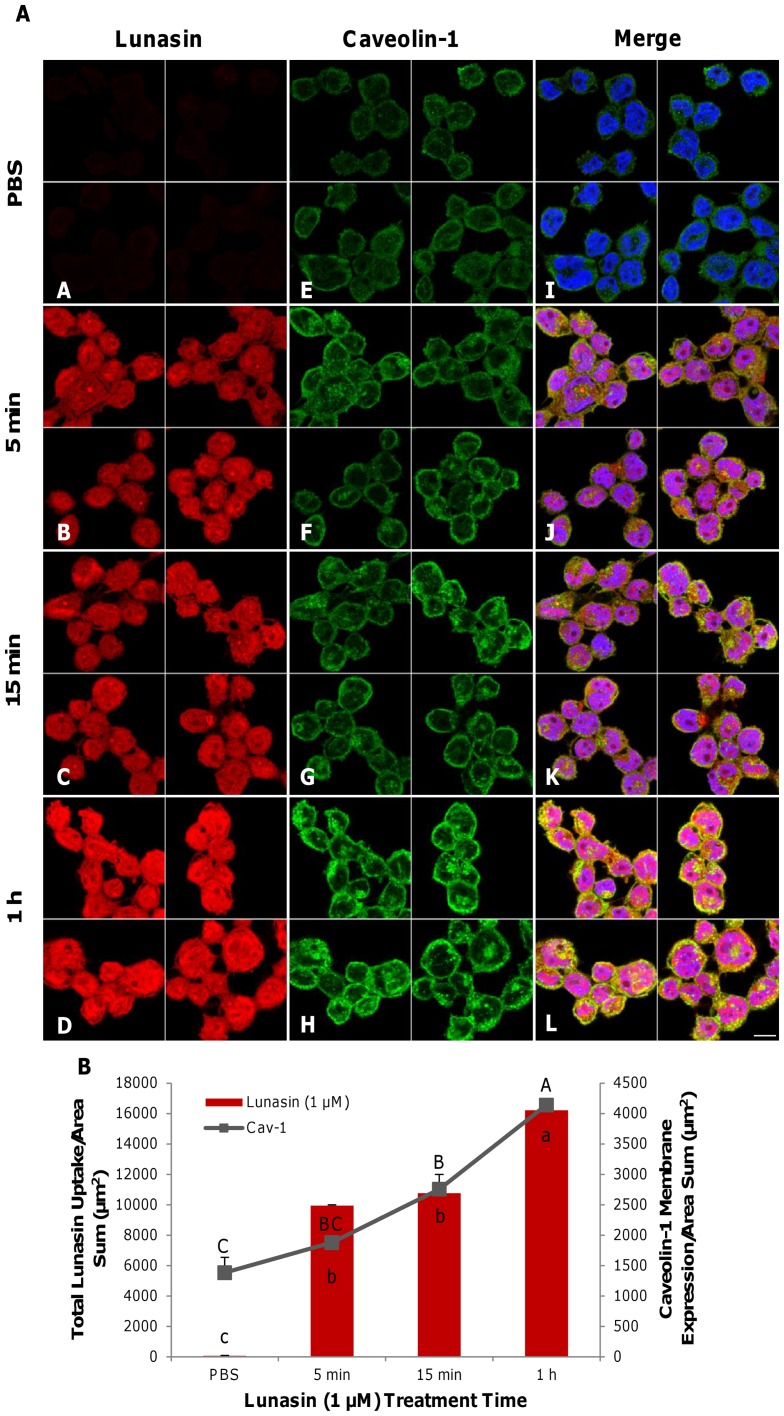
Lunasin promoted the translocation of caveolin-1 to the plasma membrane.Two-dimensional median optical planes showing immunofluorescent localization of lunasin (red), caveolin-1 (green) and nuclei (blue) (
Figure 4A
). Total lunasin uptake by macrophages increased over time (A–D) and treatment upregulated the expression of caveolin-1 at the surface of the plasma membrane (E–H). Immunofluorescence and merged image for lunasin, caveolin-1 and nuclei are shown (I–L). Quantification of the total lunasin uptake and expression of caveolin-1 at the membrane over the time-course of the lunasin treatment (
Figure 4B
). Four independent fields of view from three independent replicates of cells were merged together per treatment group. In Figure 4B, data represent the average of triplicates or quadruplicates ± SE. Capital letters denote statistical values of caveolin-1 expression, whereas lower-case letters represent the statistics for the uptake of lunasin. Means with different letters are significantly different from each other (n = 3, p<0.05). Bar  = 10 µm.